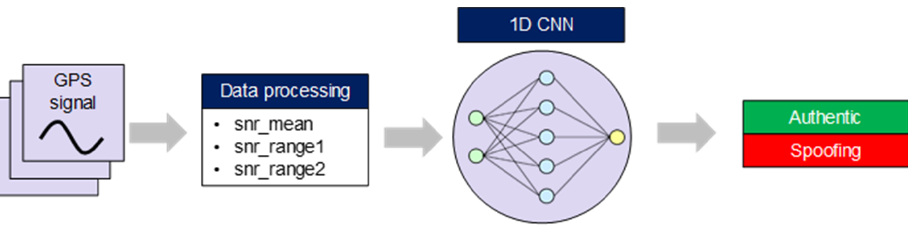
Figure 3. Spoofing detection procedure by deep learning approach.